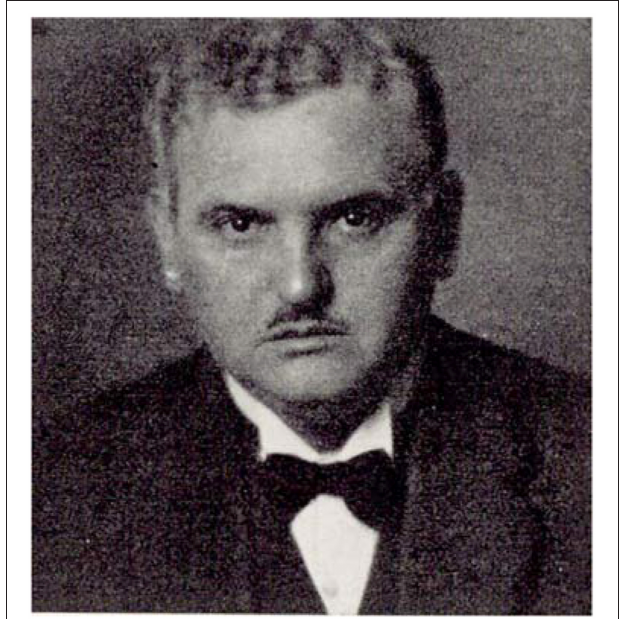
FIGURE 1 | Sven August Heintze (1881–1941) demonstrated the importance of corvids for seed dispersal in a wide range of plant species. Heintze was trained at Lund University, Sweden, where he defended his doctorate in botany in 1913. He published extensively about seed dispersal by birds and mammals in the years 1910-1918 (in Swedish), and later reached out for a wider audience in a two-volume synthesis about plant dispersal (in German; Heintze, 1932, 1935). Three of his papers provide data used for analyses in the present paper, resurrecting Heintze’s legacy as a pioneer in this